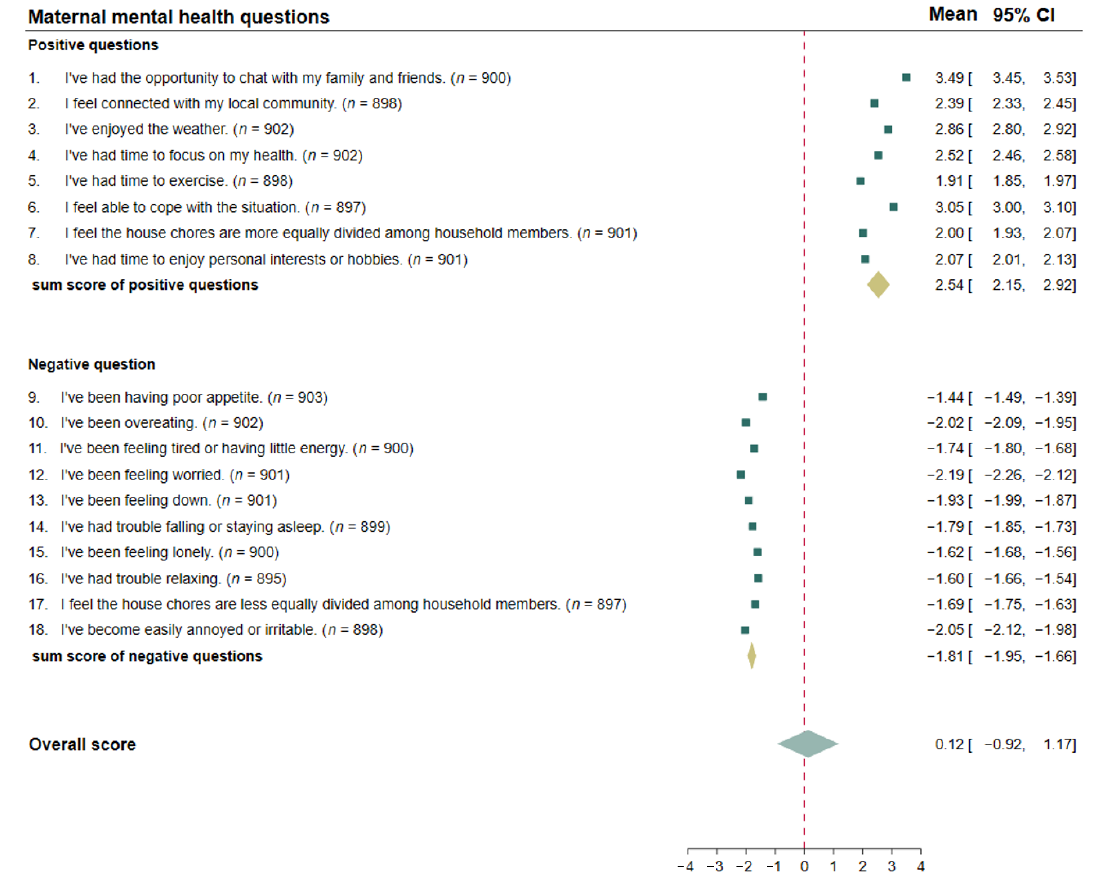
Figure 3. The estimated scores of the responses to the maternal mental health questions by forest plot.